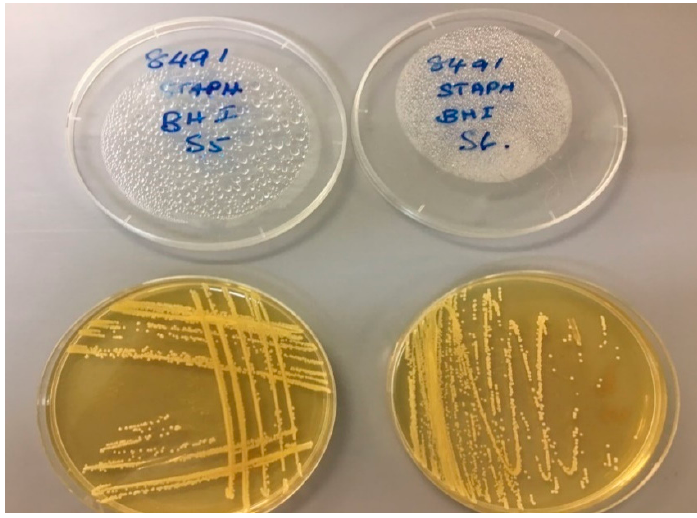
Figure 9. Confirmation of presence of Staphylococcus spp. in sample 2.